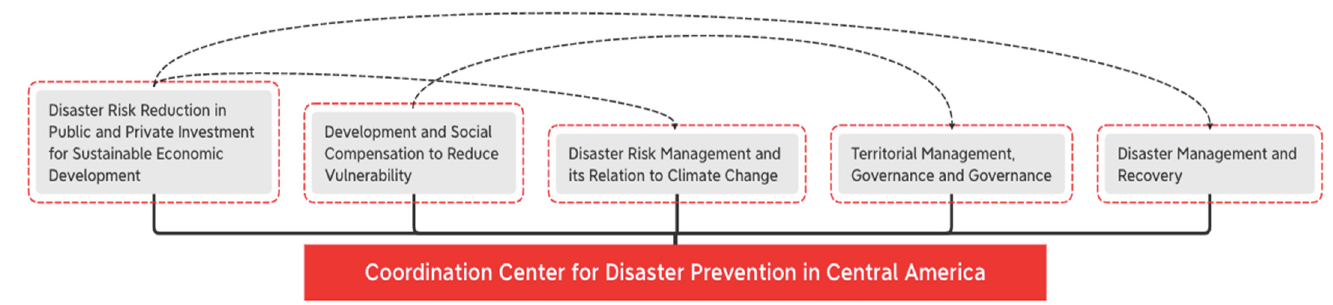
Figure 2. Coordination Center for Disaster Prevention in Central America Central Axes [5]. These central axes are inseparably integrated, and seek to contribute to the reduction of vulnerability and the impact of disasters, as an integral part of the transformation and development process of Central American integration.